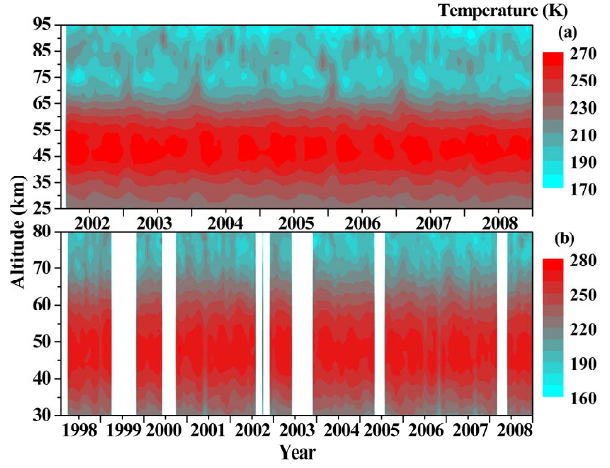
Fig.1. Contour plot of monthly mean temperatures with respect to altitude and corresponding Fig. 1. Contour plot of monthly mean temperatures with respect to month of the years for (a) SABER and (b) lidar. altitude and corresponding month of the years for (a) SABER and (b) lidar.